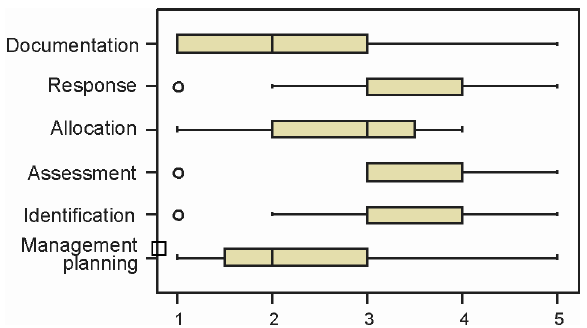
Fig. 4. Risk analysis method usage in PPP projects